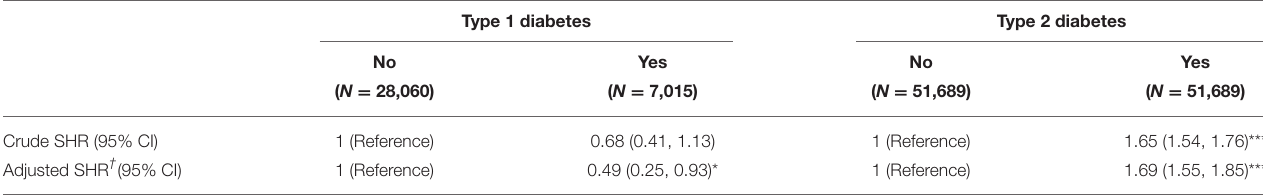
TABLE 4 | Incidence and SHRs of gallbladder stone disease in type 1 diabetes or type 2 diabetes cohort compared with the corresponding control cohort, based on the competing risk